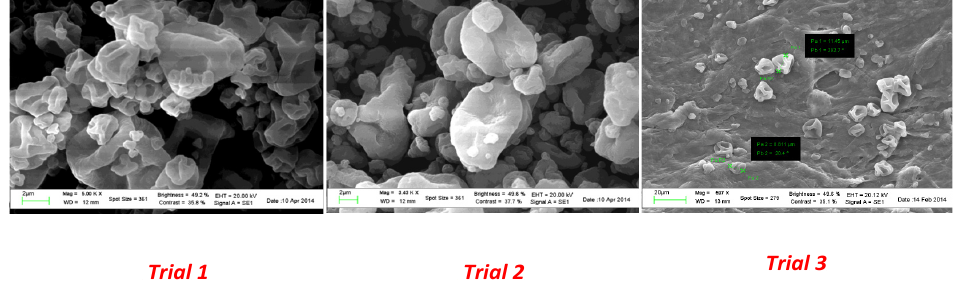
Figure 5. SEM images of microparticles from spray drying experiments after 2 h in HCl.